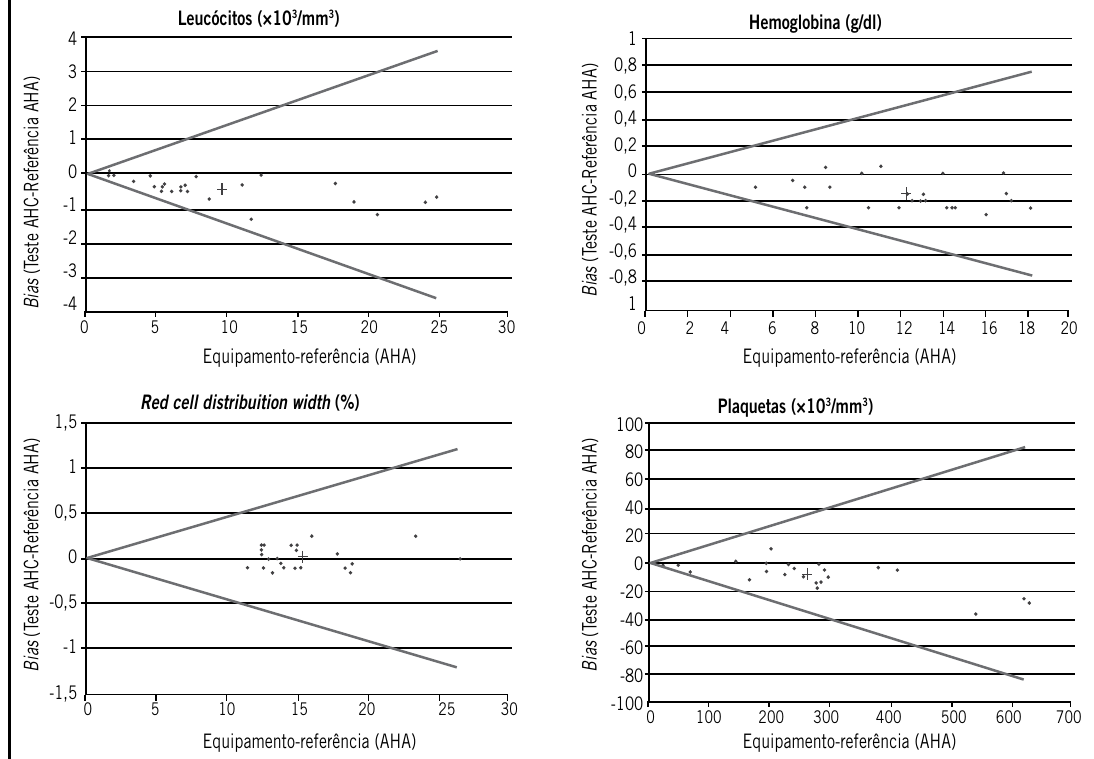
Figura 2 – Diferenças de parâmetros hematológicos entre AHC e AHA A linha < corresponde ao erro total permitido. O símbolo + corresponde ao bias médio. AHC: analisador hematológico C; AHA: analisador hematológico